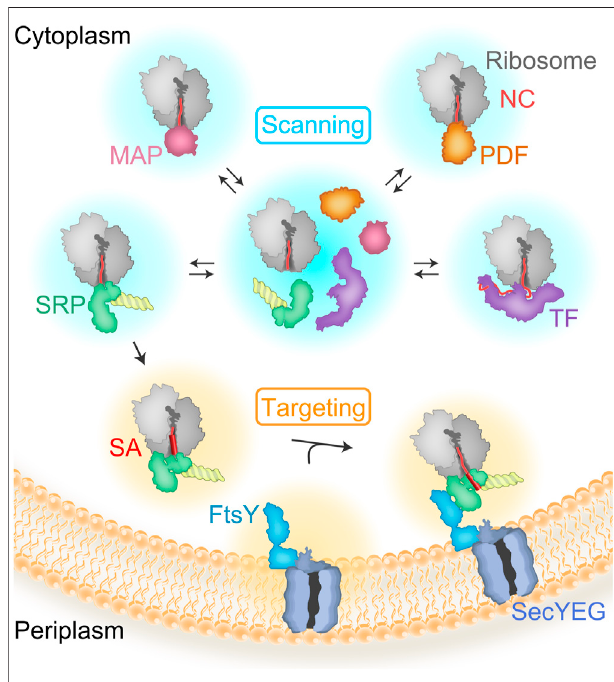
FIGURE 1 | Scanning and targeting of nascent polypeptides. RBPs rapidly bind to the ribosome during ongoing translation to scan emerging nascent polypeptide chains (NC). Most of the proteins are fi rst deformylated by PDF and then processed by MAP, which cleaves the N-terminal methionine. TF is a chaperone with preference for cytosolic or outer membraneproteins. TFandSRPcompeteforbindingtoribosomeswithshort nascent chains. Nascent peptides emerging from the exit tunnel of the ribosome expose recognition motifs leading to kinetic stabilization or rejection of TF vs SRP. SRP recognizes the signal-anchor sequence (SA) and targets the RNCs tothe translocon, SecYEG,with the help ofthe SRPreceptor,